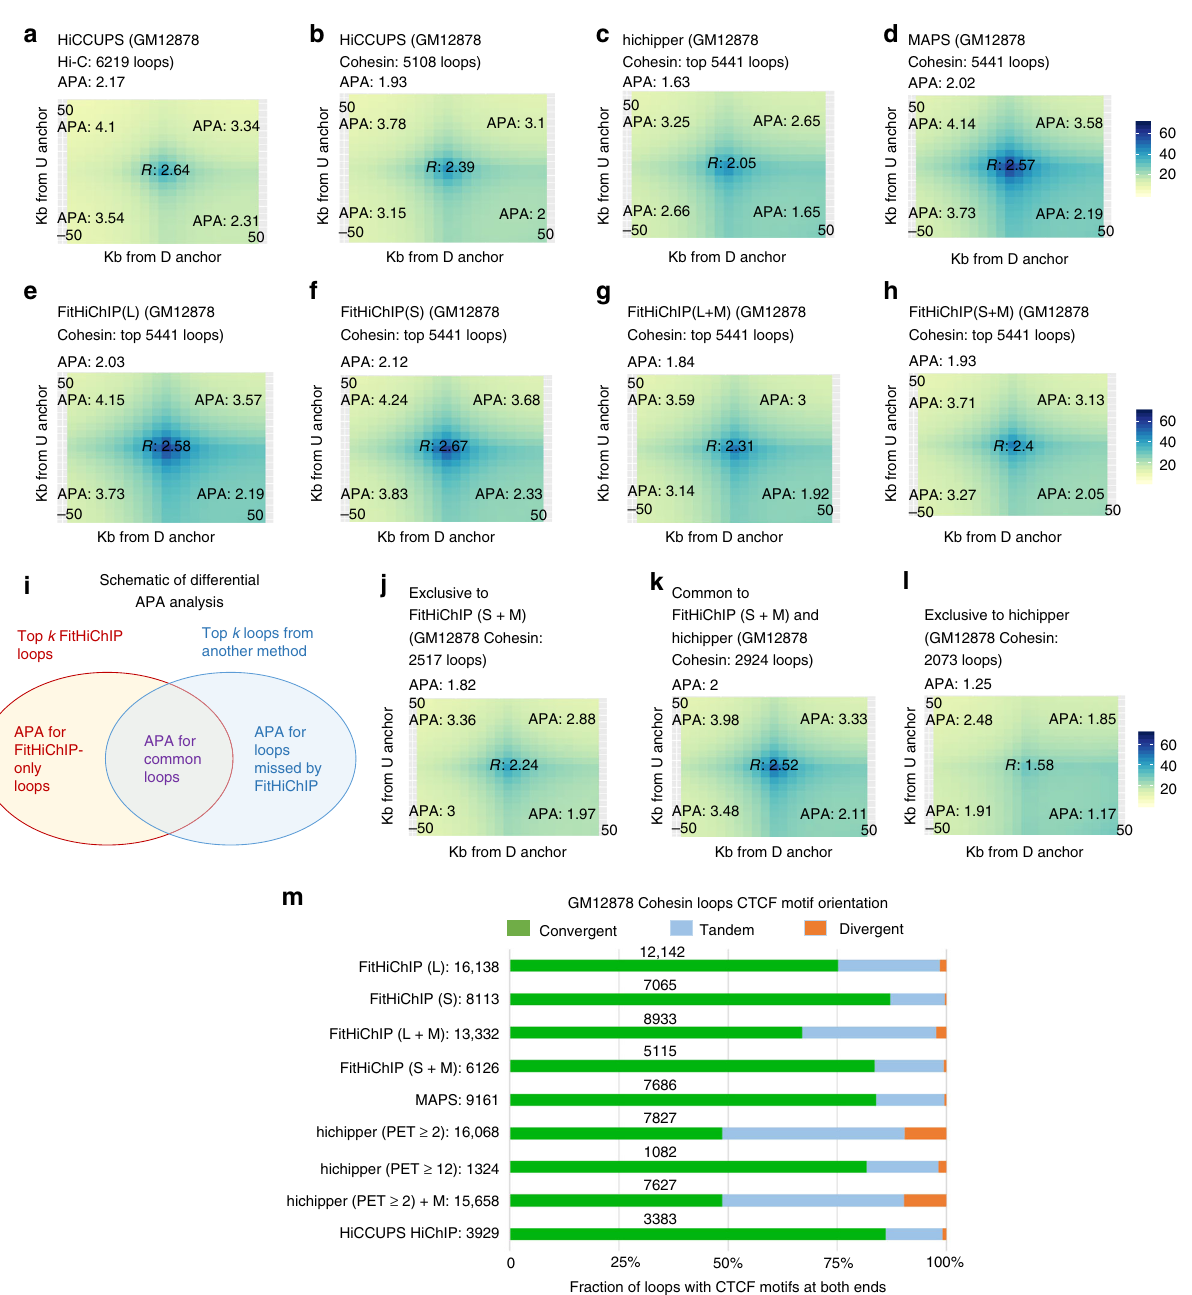
Fig. 3 FitHiChIP loops are supported by in situ Hi-C data. a APA plot for HiCCUPS loops called from GM12878 in situ Hi-C data 3 using the same dataset as the underlying contact map. b – d APA scores for HiCCUPS, hichipper, and MAPS loops computed from GM12878 cohesin HiChIP data 5 , respectively. e – h APA scores for different FitHiChIP versions for the same GM12878 cohesin HiChIP data 5 . For HiCCUPS, all 5108 reported loops are used, whereas for FitHiChIP, hichipper and MAPS, the top k loops are considered, where k = 5441 (equal to the number of GM12878 RAD21 ChIA-PET loops). (i) A schematic of the comparative APA analysis for overlapping and exclusive loops between FitHiChIP (top k loops) and a set of loops either from a reference method (containing k loops in total) or from a competing method (top k loops). j – l The results of comparative APA analysis for overlapping and exclusive loops between FitHiChIP(S + M) and hichipper for GM12878 cohesin HiChIP data 5 . For all APA plots above, the overlapping loops are determined using 5 kb slack (see Methods) and the loop calls are subsetted to the distance range of 150 kb – 1 Mb (as suggested in ref. 11 ) for each method before determining the top k . m The breakdown of HiChIP loops overlapping CTCF binding motifs on both sides with respect to CTCF binding orientation for different HiChIP loop callers. The total number of loops with CTCF motifs on both sides are listed on the left for each method and the number of those with convergent orientation (green) are overlaid on the corresponding portion. Source data are provided as a Source Data fi outperforms existing methods (Fig. 2f and Supplementary Fig. HiCCUPS on HiChIP data (Supplementary Fig. 8) or from their 16a). Due to its stringency, we also utilize HiCCUPS loop calls intersection with ChIA-PET loop calls in matching datasets on HiChIP data as a reference set in order to compare the other (Supplementary Fig. 16b, c) all show that FitHiChIP(L + M) three HiChIP loop callers. Recovery plots for loop calls from has the best overall performance in each case with MAPS